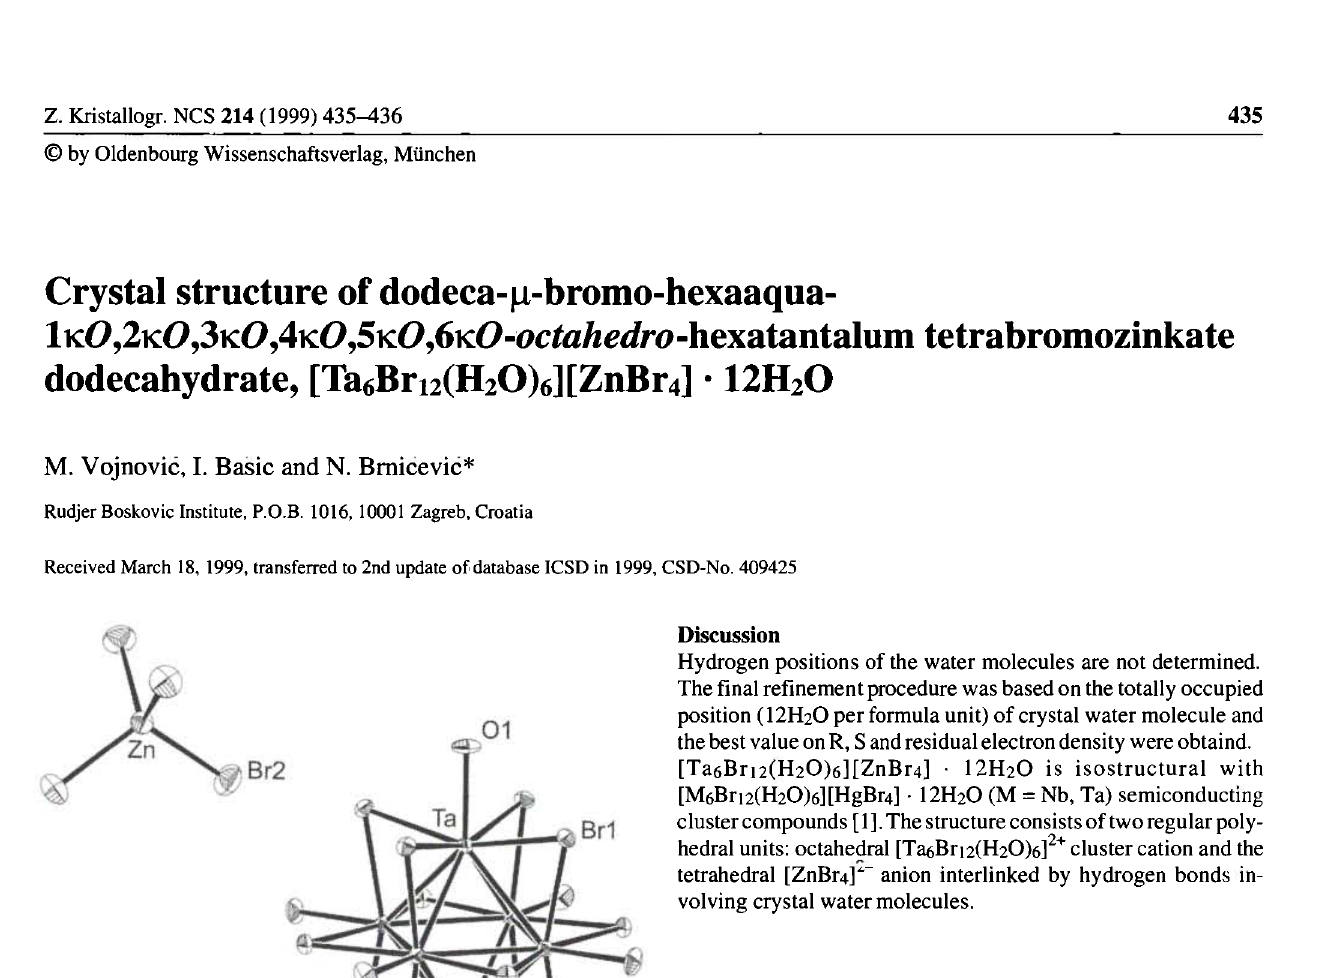
Table 1. Data collection and handling. Crystal: